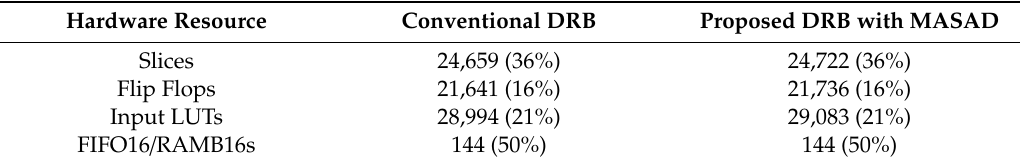
Table 1. Hardware resource of conventional and the proposed